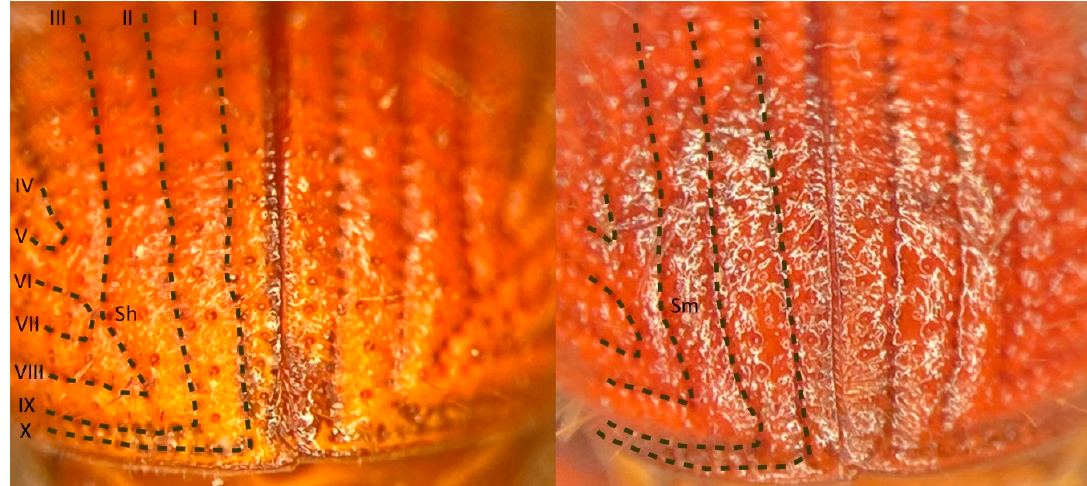
Figure 4. The striae (dashes) and interstriae in the declivity of D. rufipennis ( left ) and D. murrayanae ( right ) . Striae III curves sharply (Sh) towards the suture opposite to striae VI in D. rufipennis , but smoothly (Sm) in D. murrayanae . Photos by J. Mercado.